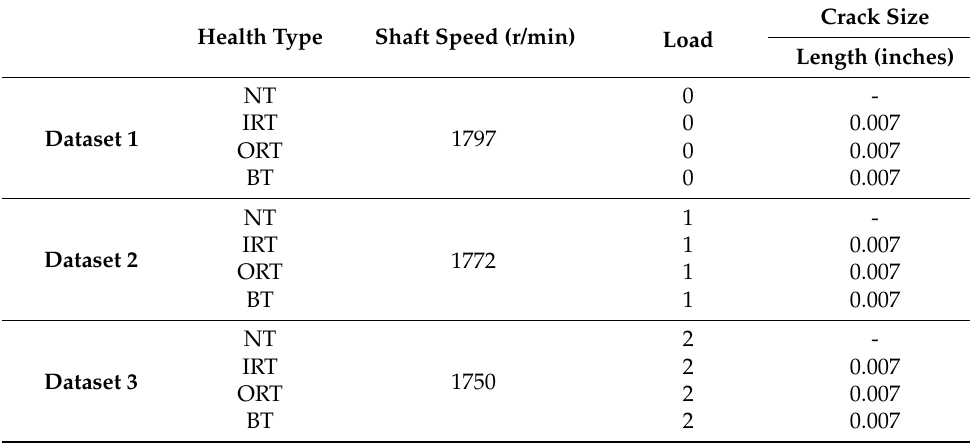
Table 8. Details of the data division.